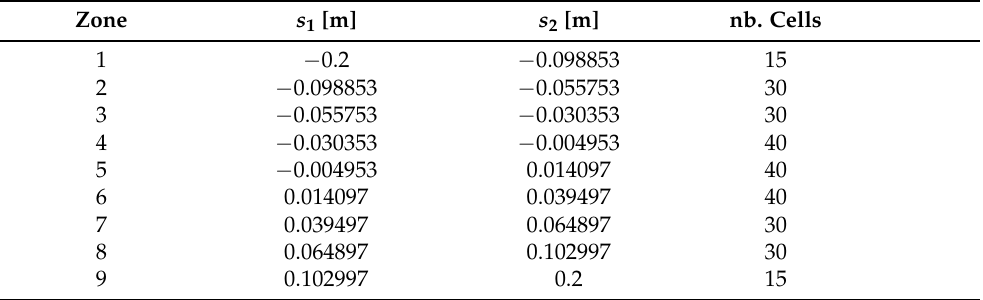
Table A4. Definition of zones in terms of starting ( s 1 ) and ending ( s 2 ) curvilinear abscissa and the associated